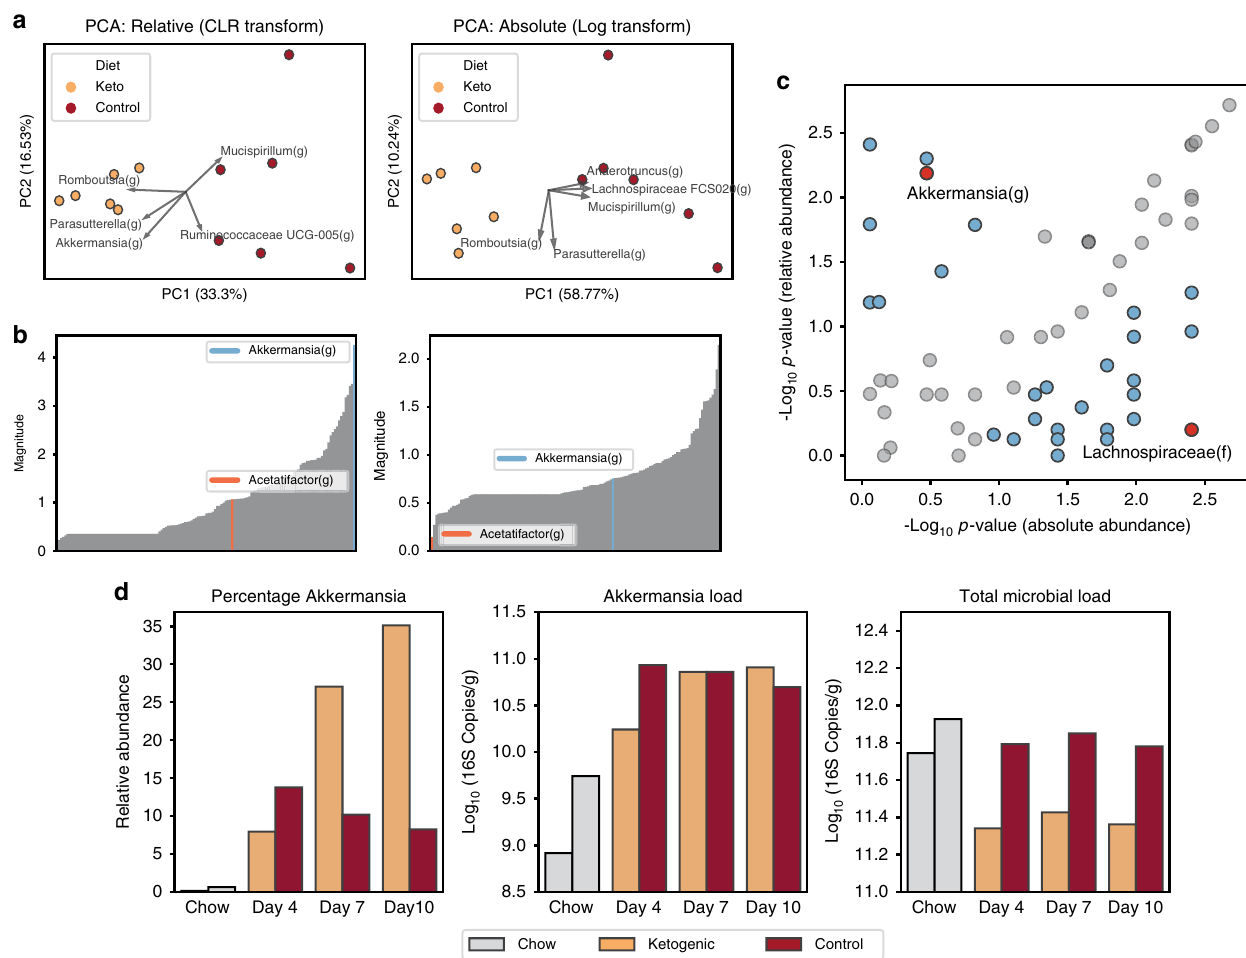
Fig. 5 Analyses of relative and absolute microbial abundances from the same dataset result in different conclusions. a PCA on centered log-ratio transformed relative abundance data and log-transformed absolute-abundance data (only the vectors of the fi ve features with the largest magnitude are shown). b The impact of each taxon in the principal component space (see text for details), with two taxa indicated to illustrate the comparison. c A comparison of the taxa determined to be signi fi cantly different between diets using relative vs. absolute quanti fi cation ( N = 6 mice per diet). P- values were determined by Kruskal – Wallis. Each point represents a single taxon; blue points indicate taxa with the absolute value of P- value ratios greater than 2.5; red points indicate two taxa that disagreed signi fi cantly between the relative and absolute analyses. d For illustrative purposes, a comparison of Akkermansia(g) relative abundance (percentage of Akkermansia), absolute abundance (Akkermansia load), and total microbial load between stool samples from one mouse on each diet (Ketogenic, orange; Control, red). Gray bars indicate loads prior to the diet switch when all mice were on the chow